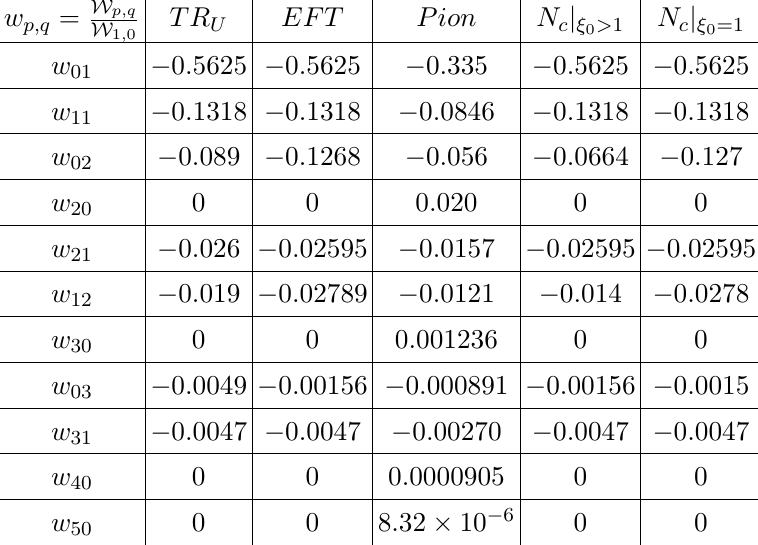
Table 1. A comparison of minimum values obtained using our results with [8, 34] and Locality constraints N for ξ = 1 and ξ 1 cases. c 0 0 >